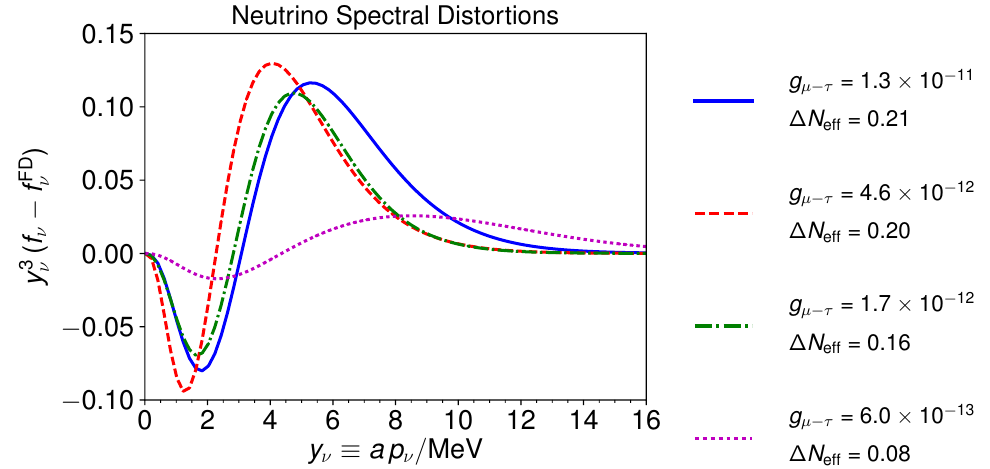
Figure 10 . The resulting neutrino distribution functions, f (cid:23) , after the Z 0 population has completely decayed as a function of the comoving momentum, y (cid:23) . f FD is the distribution function for a free- (cid:23) streaming decoupled neutrino, f FD = 1 = (1 + e y (cid:23) ). Here we have chosen m Z 0 = 2 : 2 keV. (cid:23) di(cid:11)erent from 3 T , leading to a (cid:12)nal neutrino population that is more energetic than (cid:23) that found in thermal equilibrium (as can be appreciated from (cid:12)gure 10). This results & 1 : 3 (cid:2) 10 (cid:0) 10 ( m in (cid:1) N ’ 0 : 21 for g = MeV) 1 = 2 , and to (cid:1) N < 0 : 21 for smaller (cid:22) (cid:0) (cid:28) e(cid:11) e(cid:11) Z 0 values of g (which do not enable the Z 0 population to reach thermal equilibrium with (cid:22) (cid:0) (cid:28) the